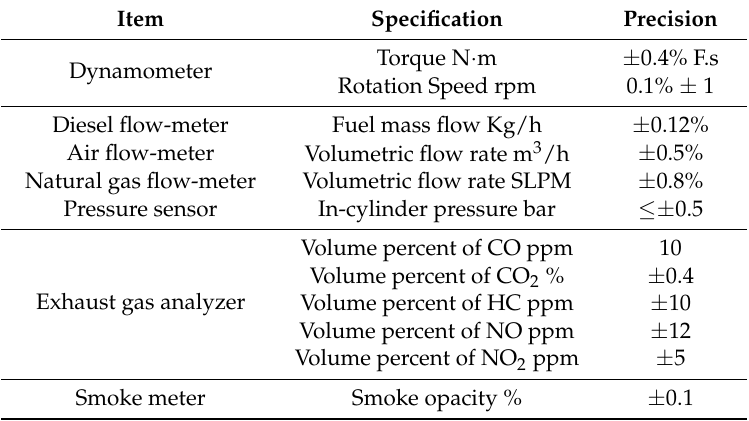
Figure 1. Dual-fuel engine test bench system. Table 2. Main instruments for experiments.